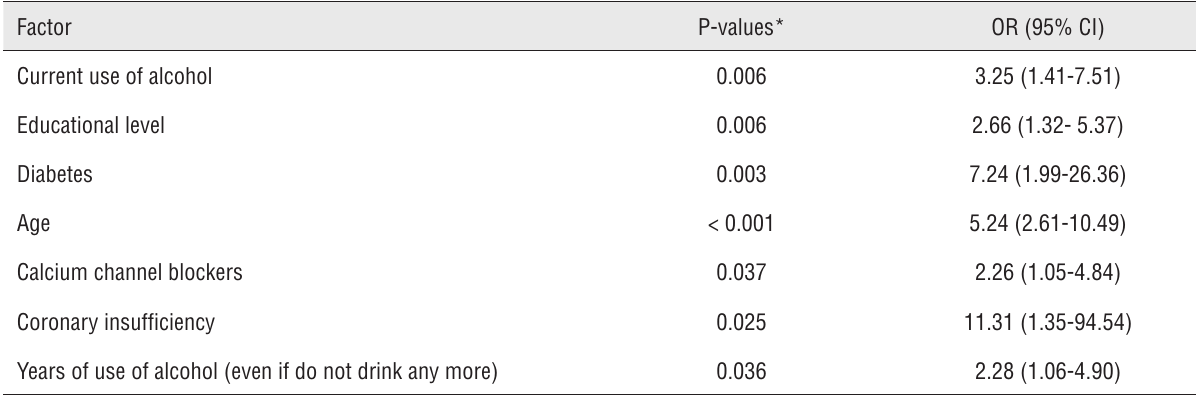
Table 7 - Model of Multivariate Regression Logistic Analysis to identify factors independently associated with erectile dysfunction in hemodialysis